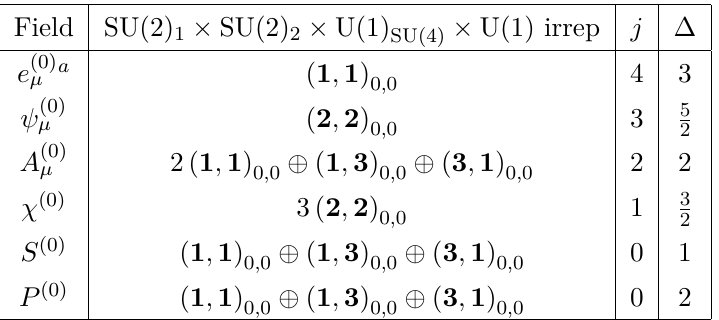
Table 6 . The KK spectrum for the level n = 0 of 11d supergravity on AdS 4 × S 7 / Z 4 p with the orbifold action in (2.9) and the periodic spin